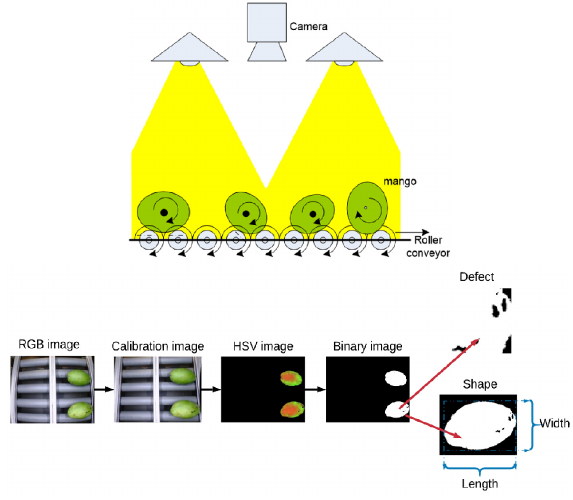
Figure 12. The process of extracting dimensions and defects of mangoes.